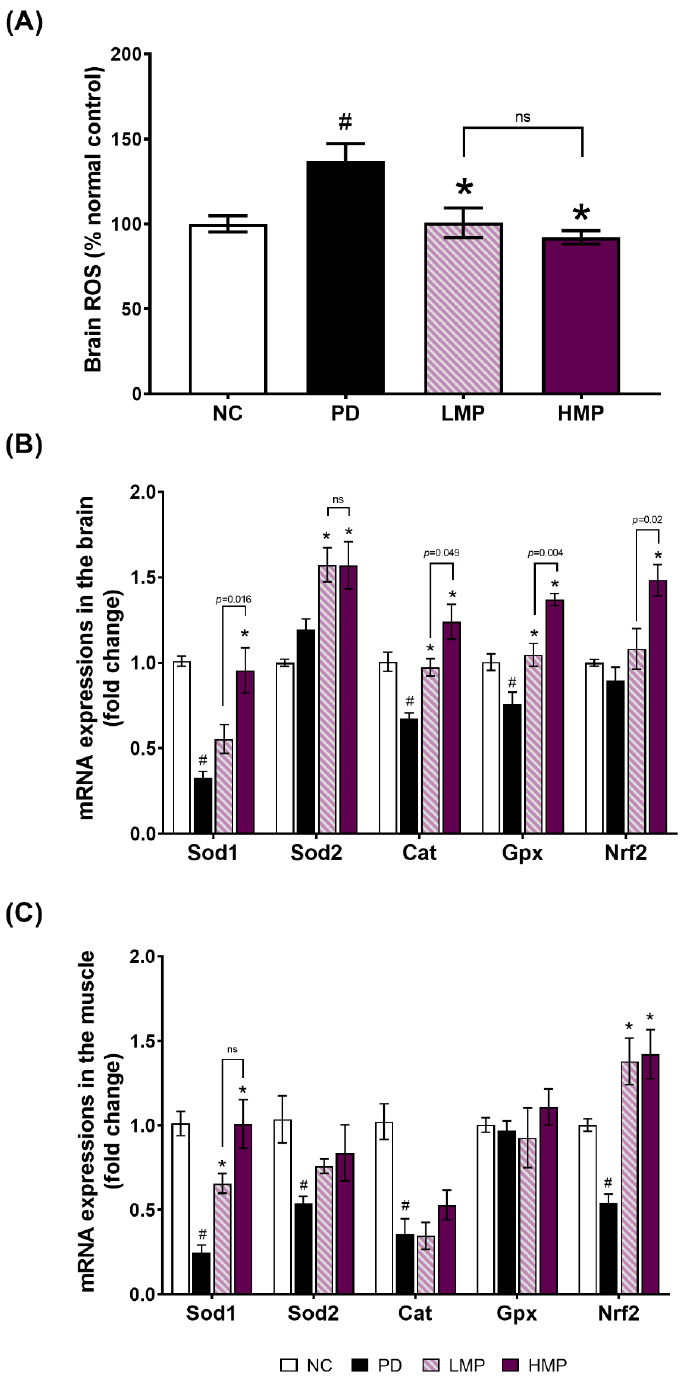
Figure 3. Levels of ROS in the brain ( A ) and antioxidant-related gene expression in ( B ) the brain and ( C ) muscle after 8 weeks of supplementation in the rat model of PD. All data are average ± SEM for n = 5 rats/group and were analyzed using one-way ANOVA with Tukey’s post hoc test. # p < 0.05 for the Parkinson’s disease (PD) group vs. normal control (NC) group, * p < 0.05 for the low-dose mangosteen pericarp (LMP) and high-dose mangosteen pericarp (HMP) groups vs. the PD group. Sod , superoxide dismutase; Cat , catalase; Gpx , glutathione peroxidase; Nrf2 , nuclear factor-erythroid factor 2-related factor 2. ns, not significant.